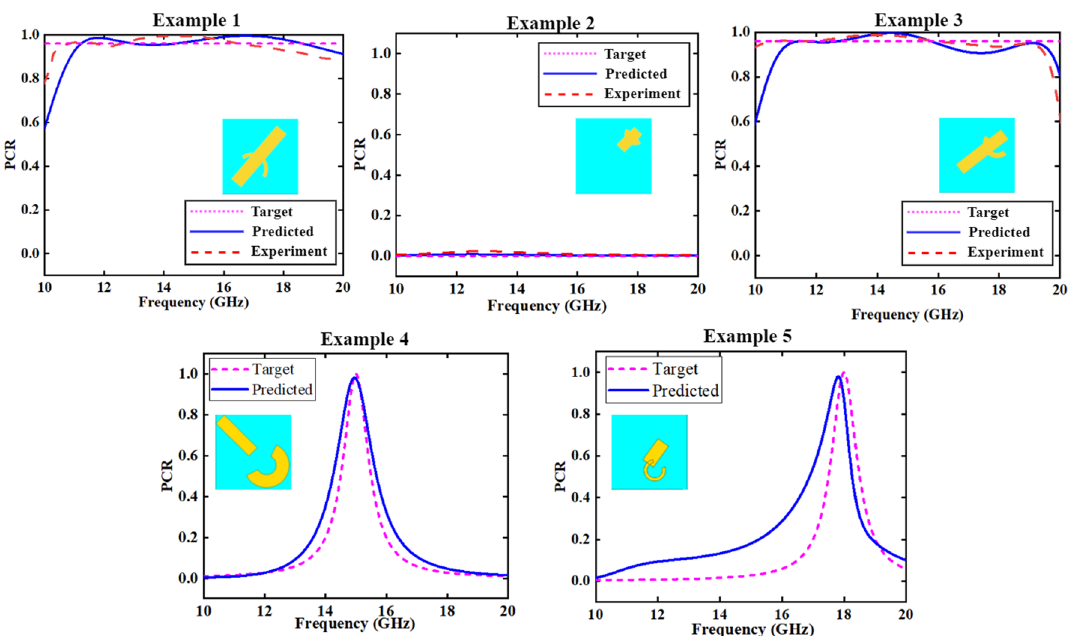
Figure 7. Comparison between target data, predicted data, and experiment data for broadband frequency of Examples 1, 2, and 3; Comparison between target data and predicted data for single frequency points of Example 4 and Example 5. (Plotted in OriginPro